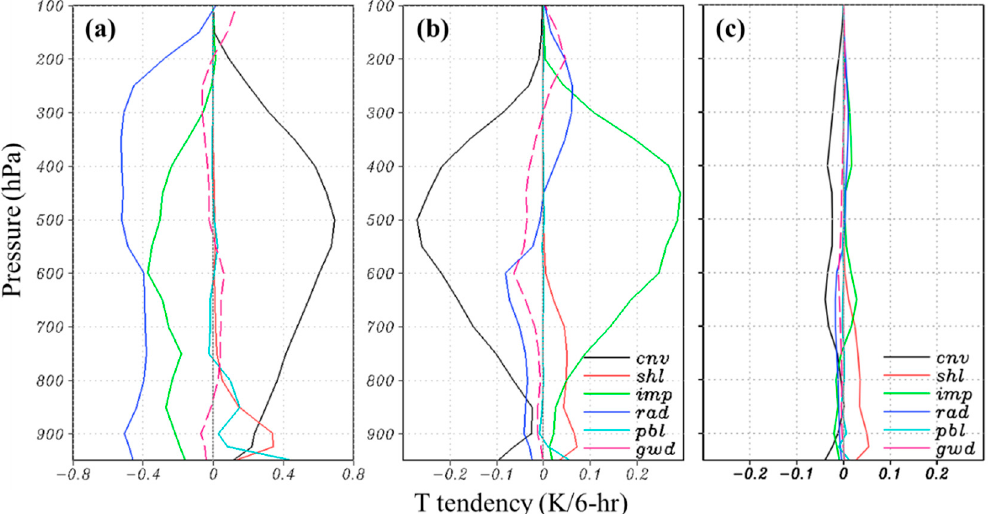
Figure 10. Vertical profile of temperature tendencies (K/6 h) due to the different physical processes in CWB FV3GFS averaged over Asia ( −5 ° N~ 55 ° N, 60 ° E~ 180 ° E) for 96~120 h forecast based on 32 daily cases from 0000 UTC 15 May 2020 to 0000 UTC 15 June 2020 from ( a ) CTRL experiment and the effects of ( b ) EXP and ( c ) EXPM experiments.